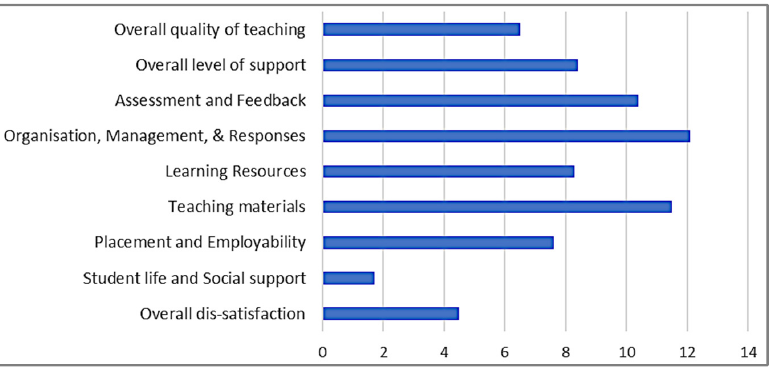
Figure 3. Relative frequency (%) of negative responses per category in the annotation scheme developed.